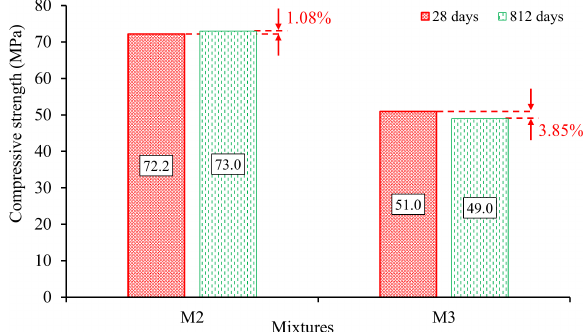
Fig. 8. The residual compressive strength of concrete after 812 days in the marine